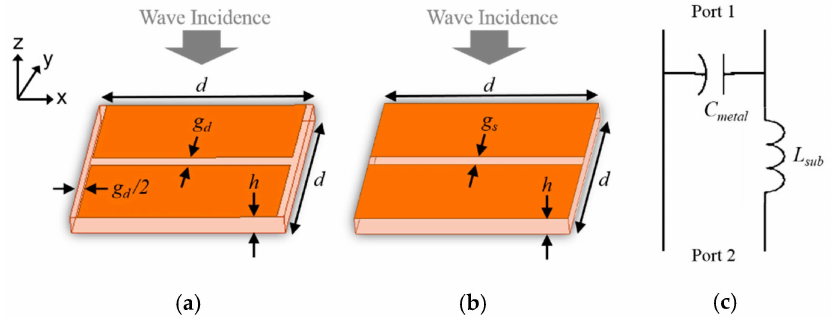
Figure 1. ( a ) Conventional dual-pol patch, ( b ) proposed single-pol patch, and ( c ) equivalent circuit of the patch.